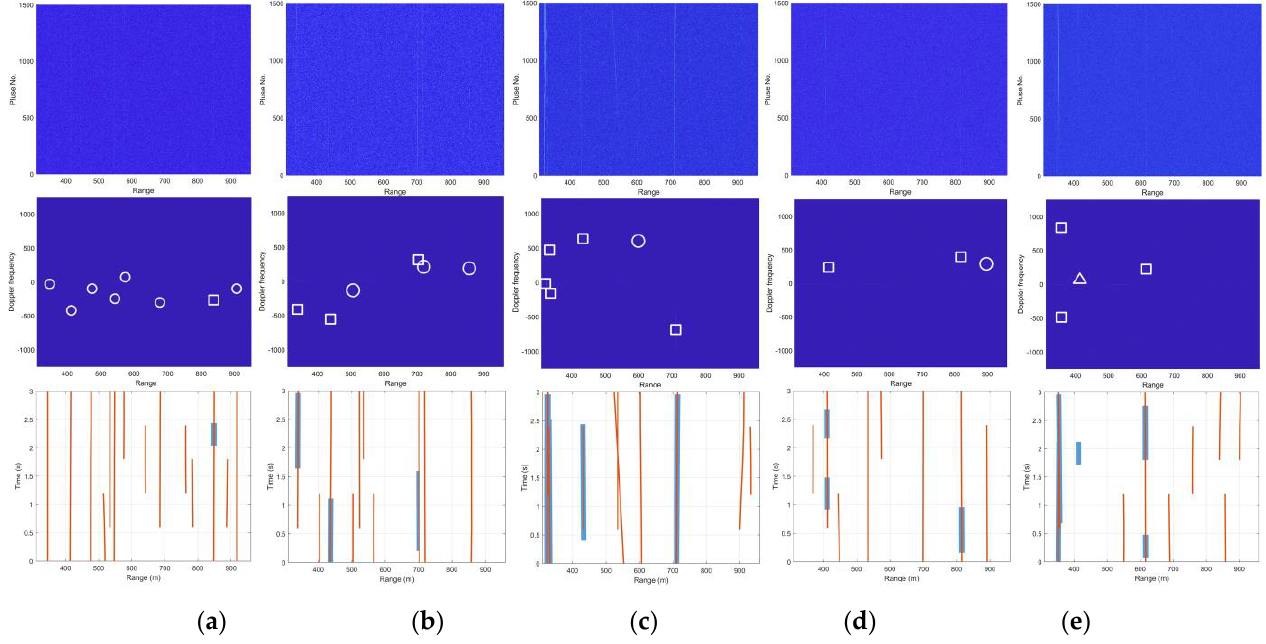
Figure 12. Typical detection results of insect observation after pulse compression (PC), MTD, BMMO, and PD-CFAR processing; the first row contains PC results, the second row contains MTD results, and the third row contains the tracks obtained by PD-CFAR marked with thick blue lines and BMMO marked with thin red lines.